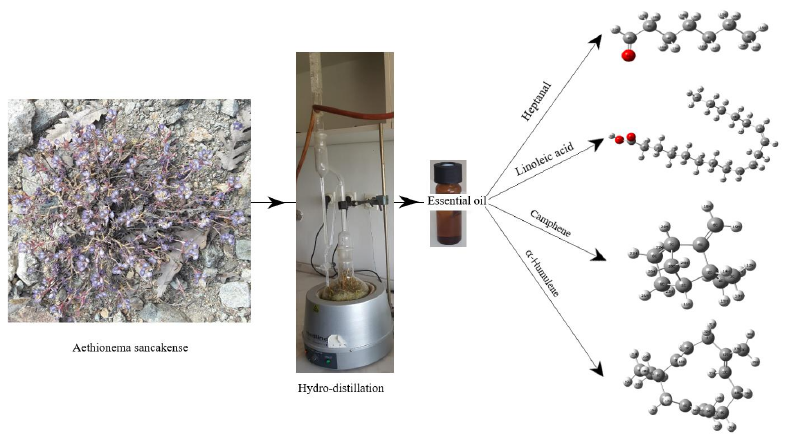
Figure 1. Analysis scheme for essential oil contents of the Aethionema sancakense plant.